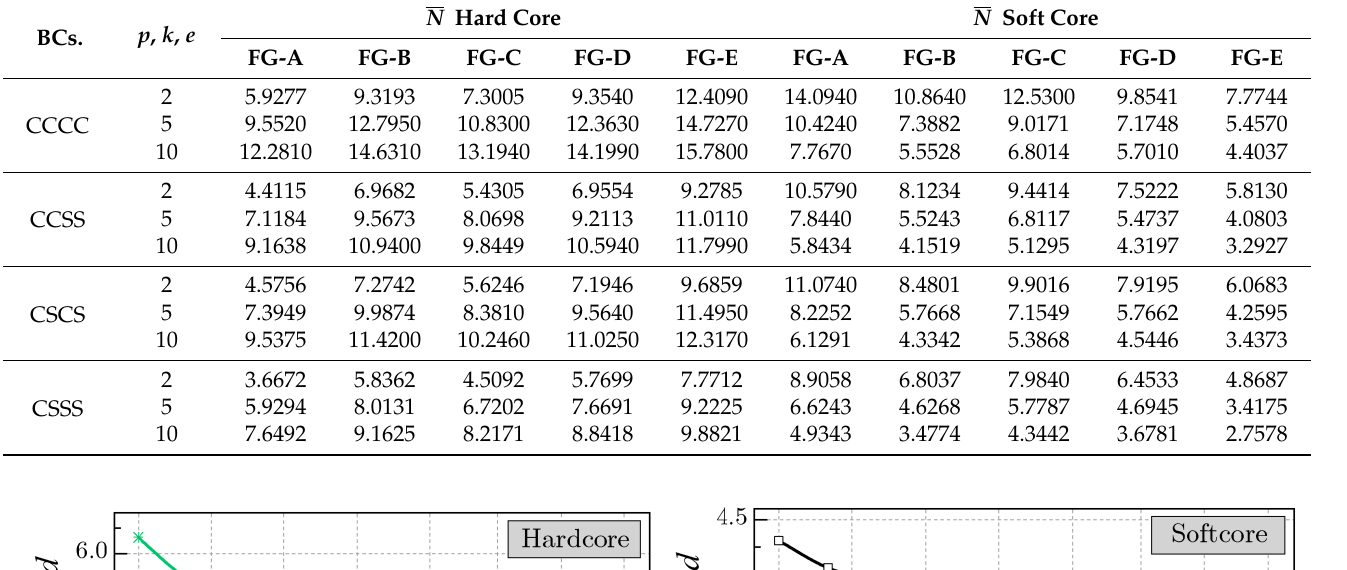
Figure 7. Effect of the shell geometry on the dimensionless critical buckling load 𝑁 ̅ of coated FG shells (𝑆𝑆𝑆𝑆, 𝑅 = 5, 𝑝 = 𝑘 = 𝑒 = 2, 𝑏 = 𝑎 = 10ℎ, 𝜇 = 𝜆 = 𝐺 𝜁 = 𝐺 𝜂 = 𝐾 𝑤 = 0) .